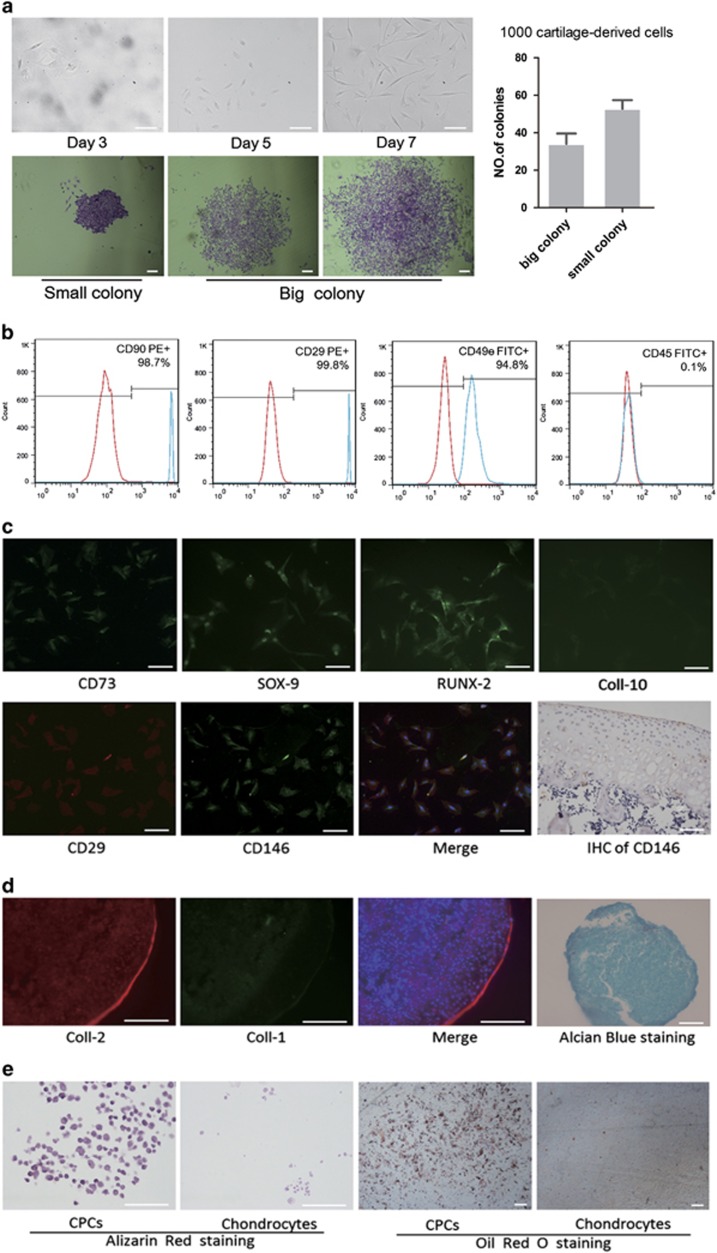
Isolation and characterization of and multipotent differentiation ability in CPCs. (a) Morphological characteristics are shown for colonies obtained from full-thickness cartilage after cells were cultured for 3, 5 or 7 days (magnification, × 200). The colonies were stained with crystal violet, and the colony-forming efficiency of the rat cartilage-derived cells was analysed on day 10. The results are shown as the mean±S.E.M. (b) Flow cytometric analysis of CPCs surface markers. Note that stem cell-relevant markers, such as CD29, CD90 and CD49e, are positive but that haematopoietic markers, such as CD45, are negative. (c) Immunofluorescence results for marker proteins (CD73, CD146, SOX-9, RUNX-2 and Coll-10) that were used to identify and characterize the colonies (magnification, × 200). The results of immunocytochemistry revealed that CD146-positive cells are primarily distributed throughout the surface layer in the knee tissues of 8-week-old SD rats. The multidifferentiation potential of CPCs in vitro. (c) Pellets of CPCs were assessed using double-labelled immunofluorescence for Coll-2 and Coll-1 (magnification, × 400) and Alcian Blue staining (magnification, × 200). (e) Alizarin Red S staining was used to evaluate osteogenic differentiation in CPCs and chondrocytes (magnification, × 400). (Oil red O staining was used to evaluate adipogenic differentiation in CPCs and chondrocytes (magnification, × 40). Scale bar, 100 μm